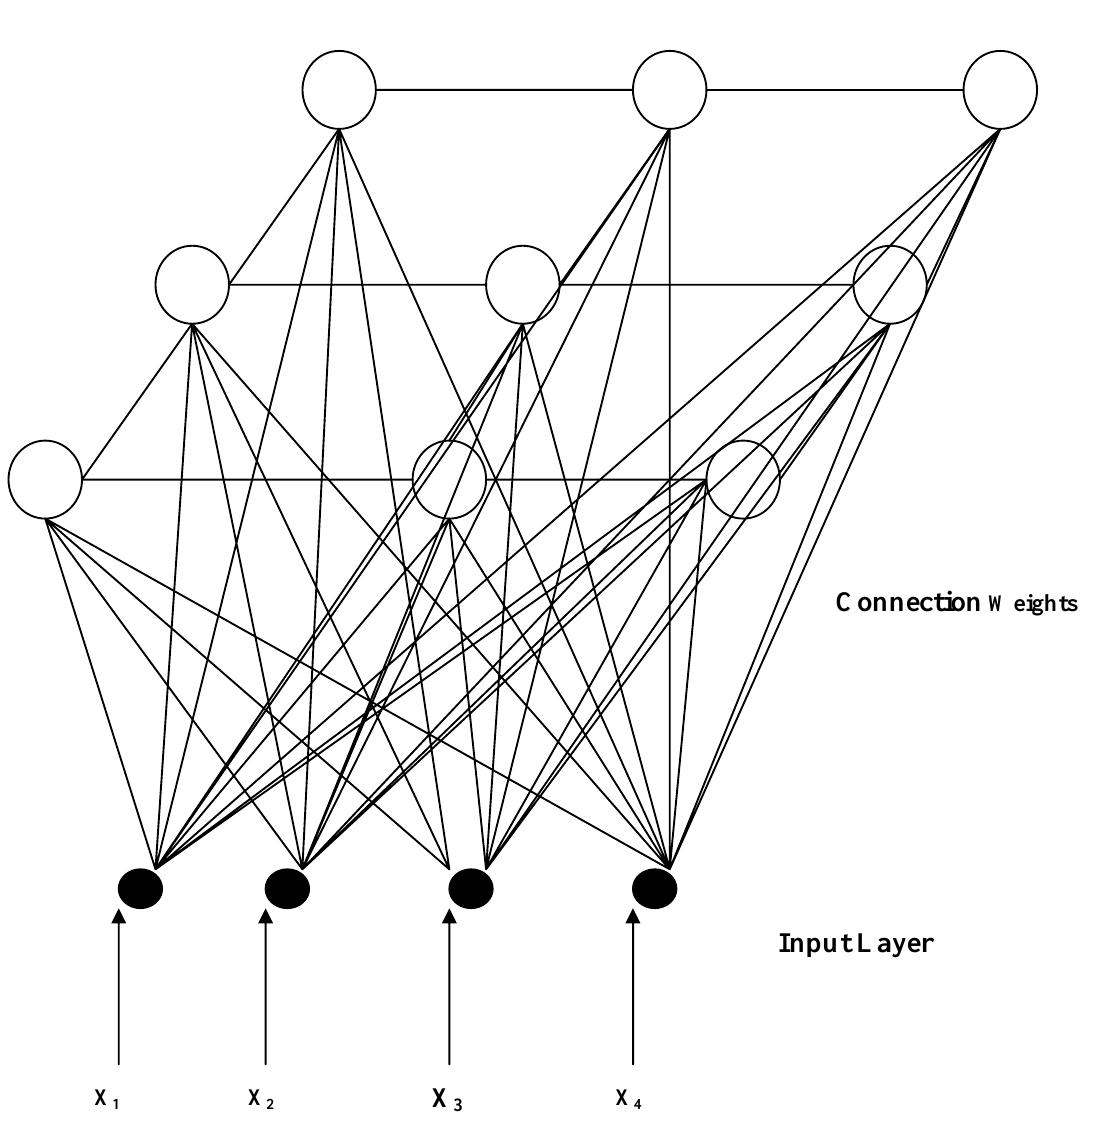
Figure 2. The structure of Kohonen’s Self-Organization Mapping neural